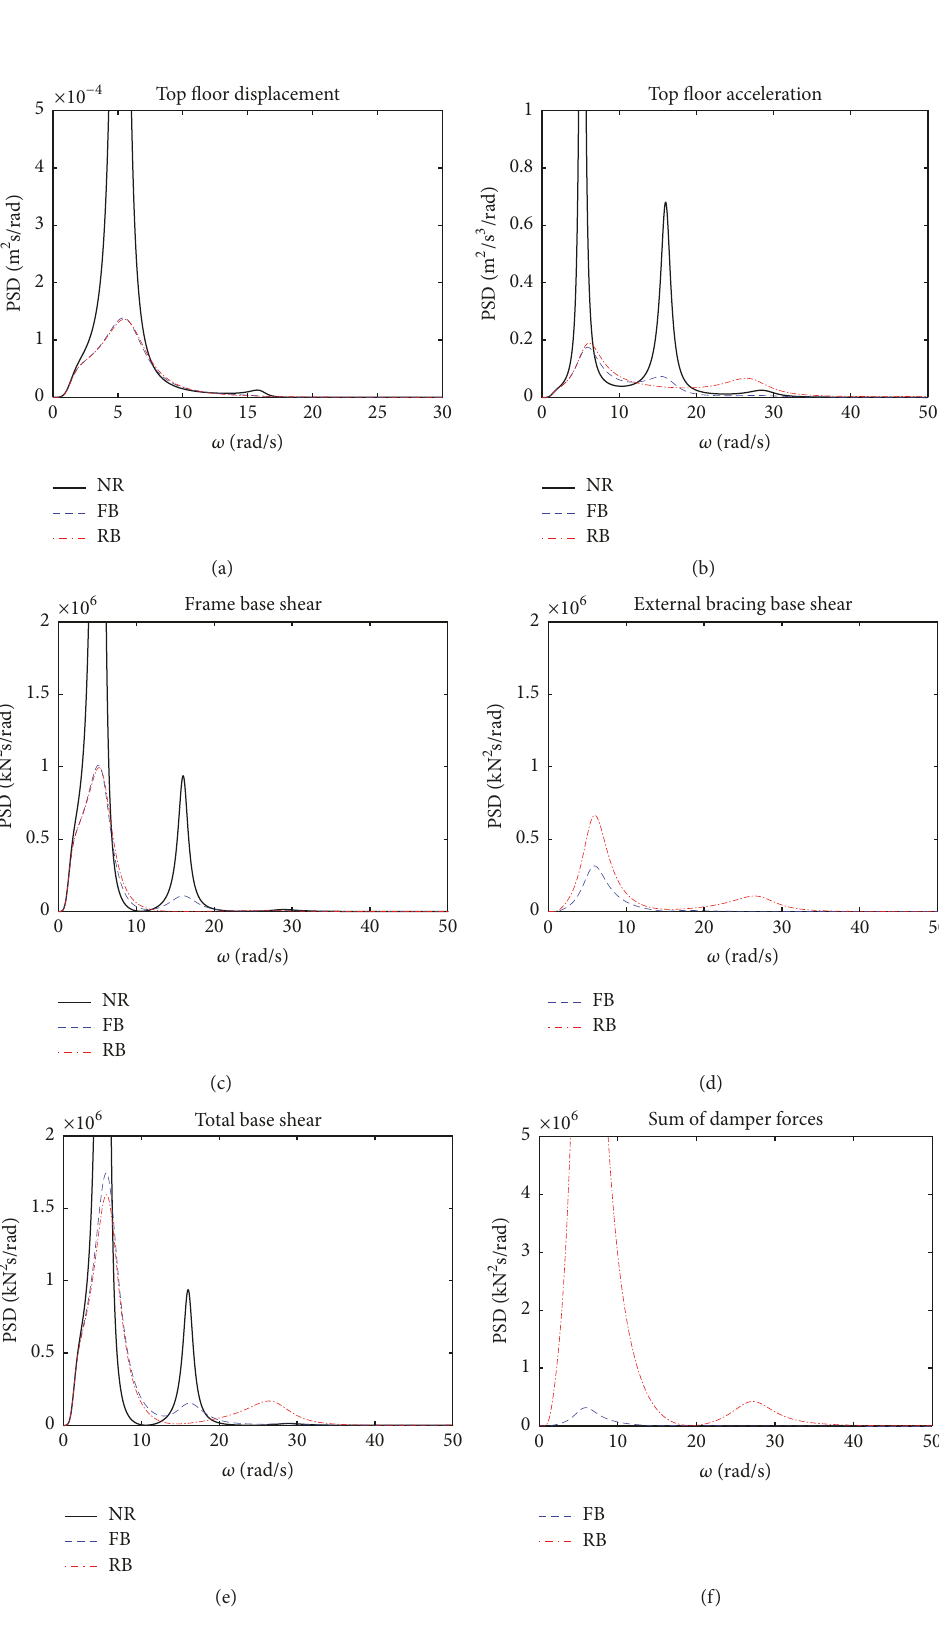
Figure 7: PSD of the response parameters of interest for the NR, FB, and RB